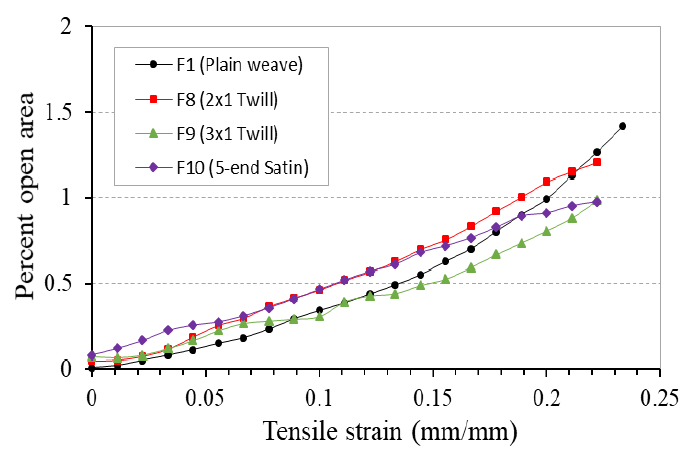
Figure 20. Percent open area-tensile strain curves of fabrics F1, F8, F9, and F10 made of different weave structures.